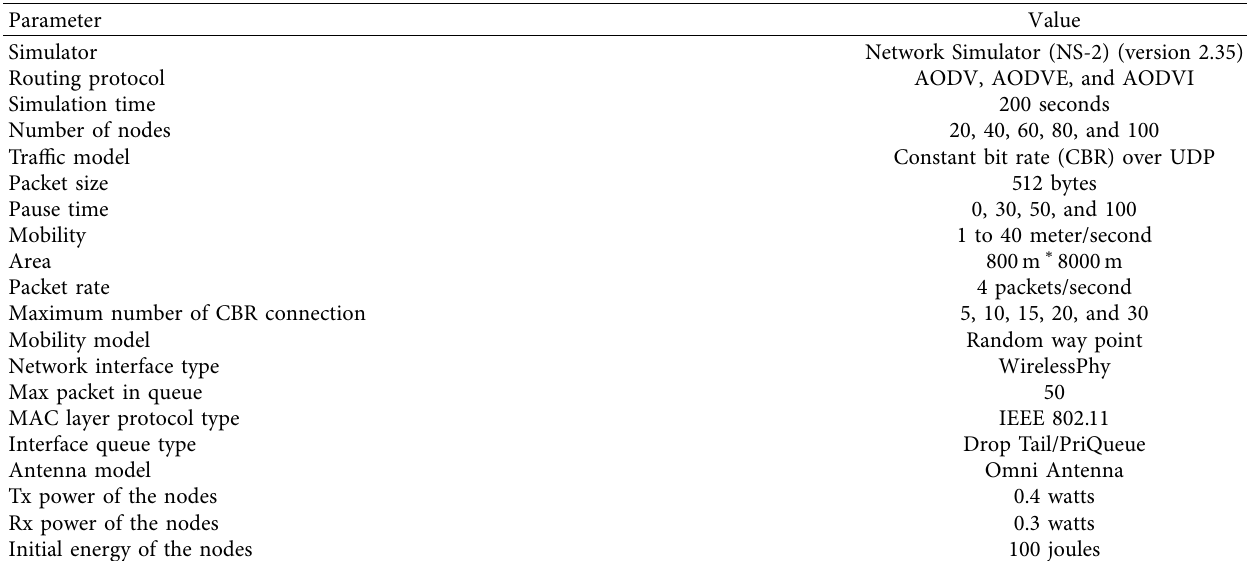
Figure 4: AODVI RREQ mechanism. Table 2: Simulation